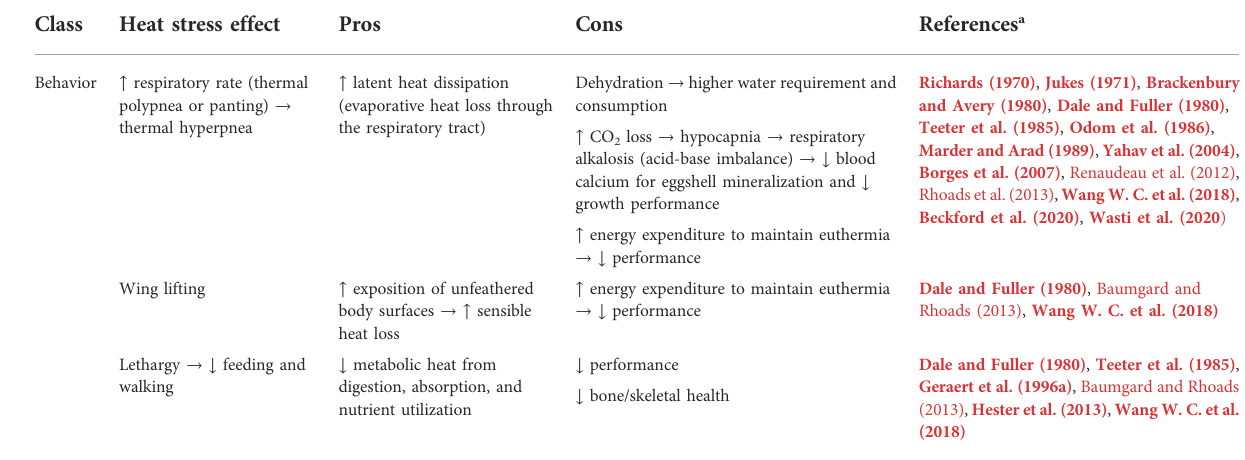
TABLE 1 Overview of heat stress effects on chicken behavior.